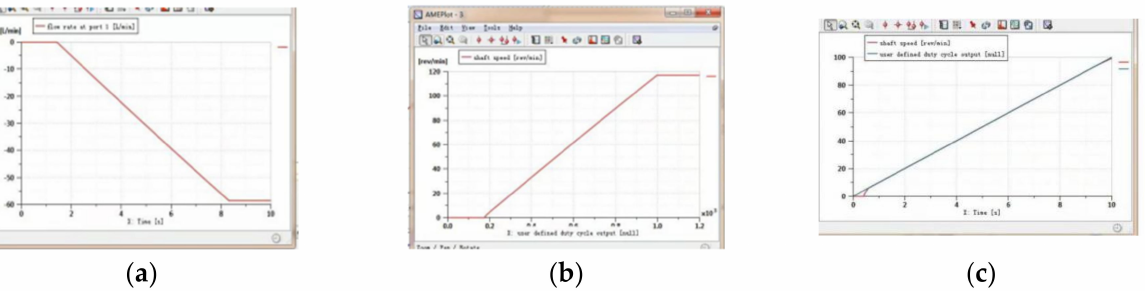
Figure 12. Simulation results of closed-loop system of hydraulic motor controlled by proportional solenoid valve. ( a ) Time-dependent flow chart. ( b ) Variation diagram of rotational speed with electrical signal. ( c ) Time-dependent diagram of rotational